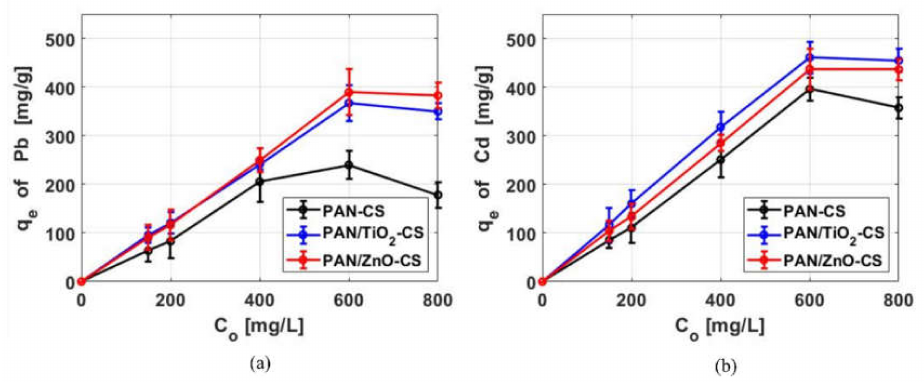
Figure 8. Equilibrium adsorption of ( a ) lead and ( b ) cadmium ions at di ff erent initial concentrations using the bilayer mats at room temperature.